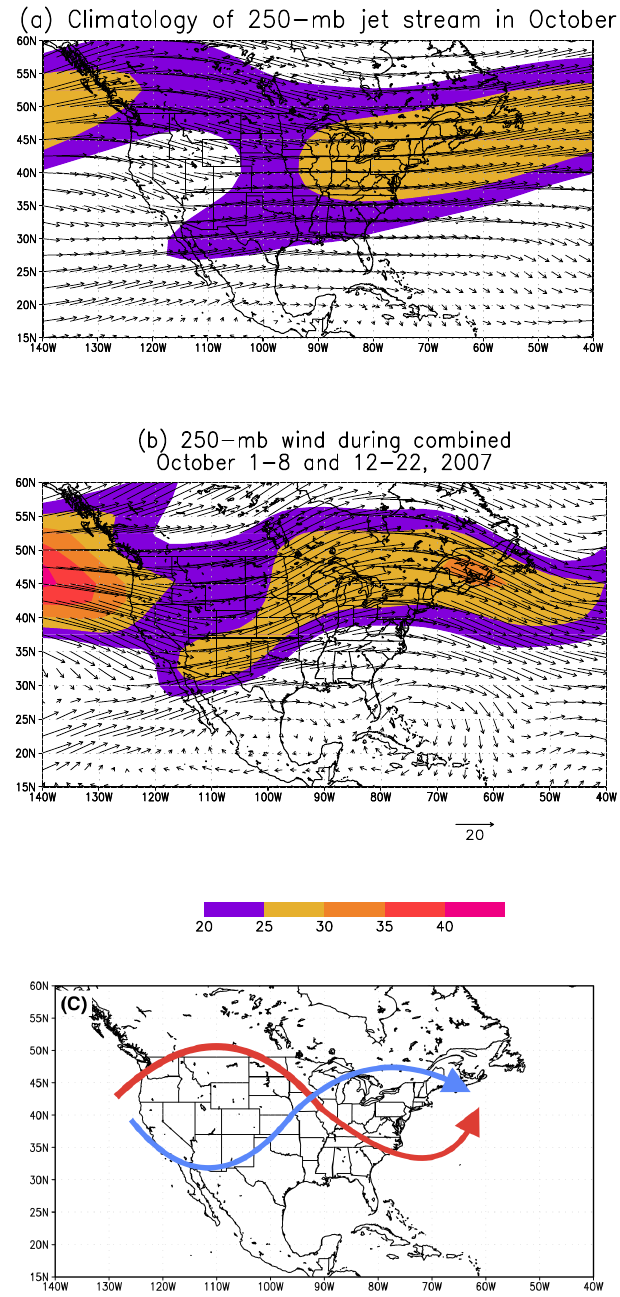
Figure 3. 250-mb wind vector (arrow) and magnitude (ms − 1 , color shade) for the October climatology in ( a ) and for the predefined sub-period of the October 2007 in ( b ), respectively. The schematic illustrations of the October climatological jet stream (red) and 2007 October jet stream over the predefined sub-period (blue) are in ( c